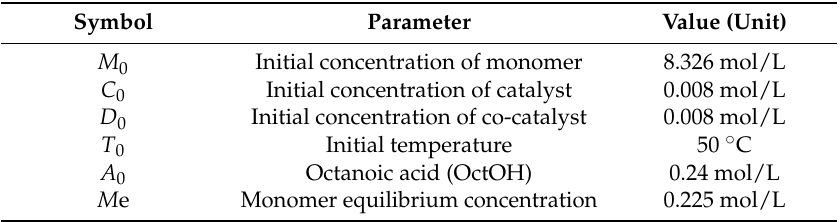
Table 4. Initial reaction parameters for